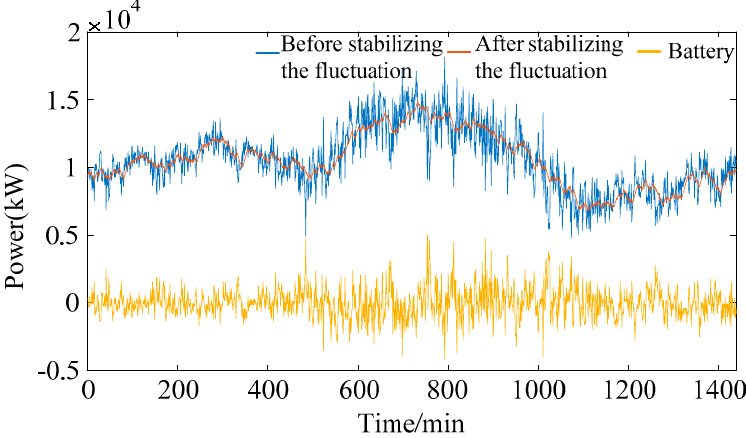
Figure 10. System output before and after stabilizing fluctuation in scenario 2. Table 8. Maximum fluctuation of system output.